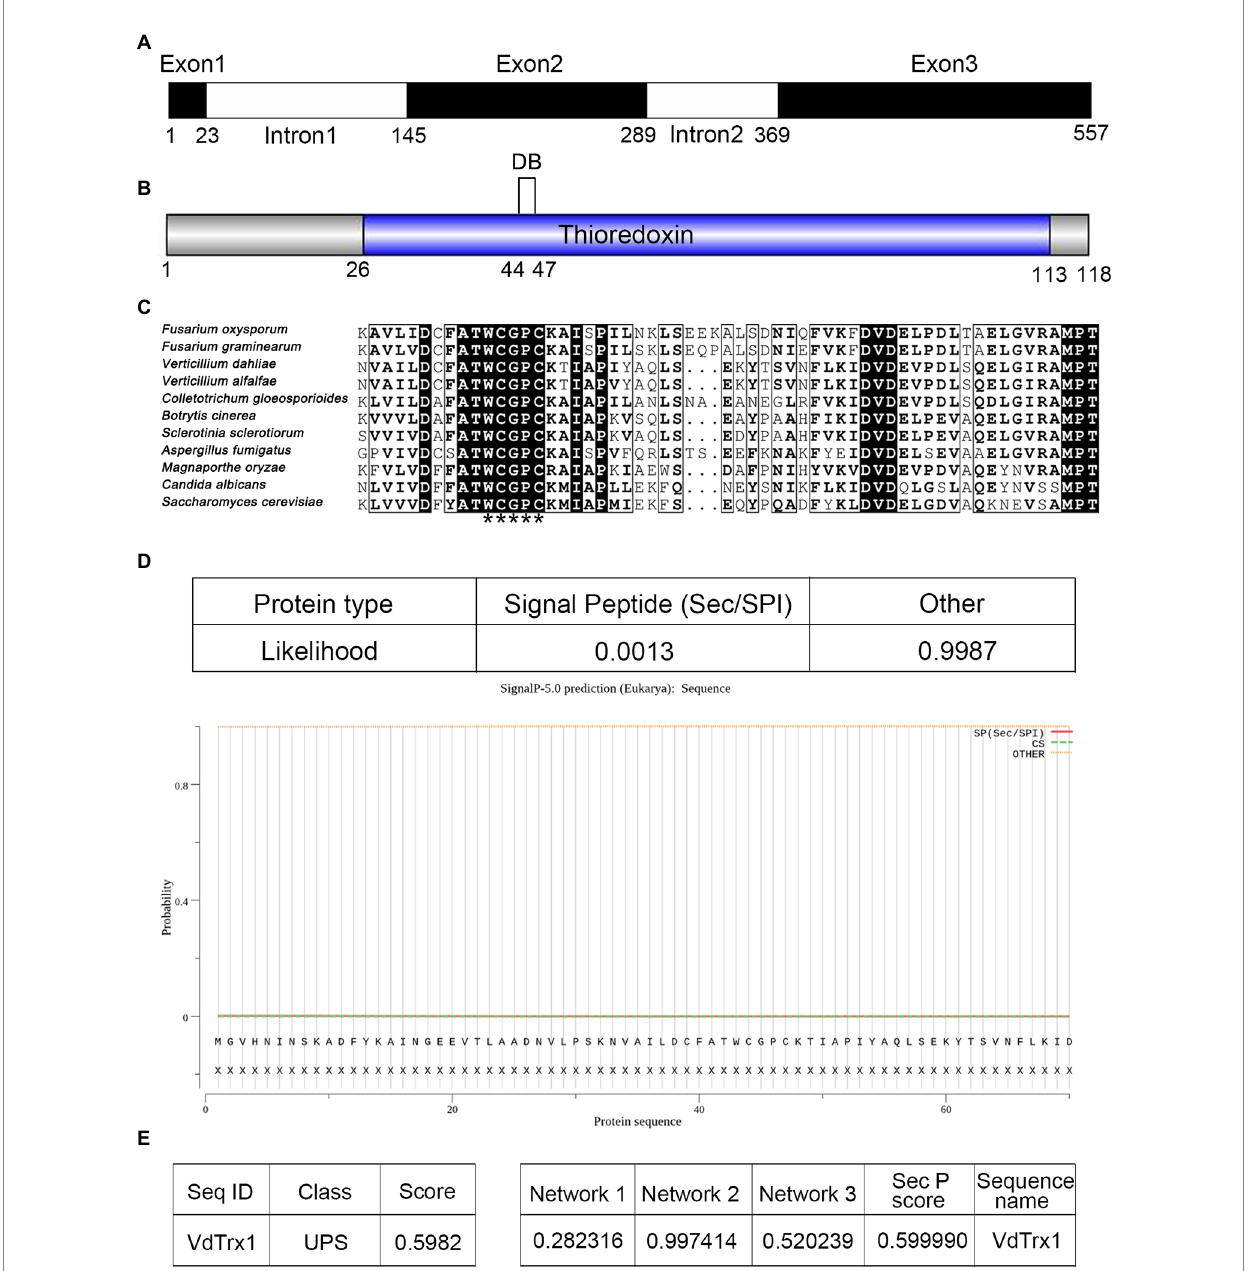
FIGURE 1 Gene cloning and bioinformatic analysis of VdTrx1 from Verticillium dahliae . (A) Structure of VdTrx1 . Exons are black boxes and introns are white boxes. (B) Conserved domain of VdTrx1 predicted by CD-Search of NCBI. DB represent disulfide bond. (C) Alignment of conserved region of thioredoxins. Thioredoxin-specific redox-active sites are marked by asterisks. GenBank accession number of aligned sequences are V. dahliae (VEDA_00080); Verticillium alfalfae (XP_003005517.1); Fusarium oxysporum (EGU81922.1); Fusarium graminearum (ESU16261.1); Magnaporthe oryzae (EHA47211.1); Botrytis cinerea (EMR86794.1); Aspergillus fumigatus (XP_753517.1); Colletotrichum gloeosporioides (EQB49288.1); Candida albicans (XP_719372.1); Saccharomyces cerevisiae (YLR043C). (D) Signal peptide prediction of VdTrx1 using SignalP 5.0 program. OutCyte 1.0 (E) and SecretomeP 2.0 (F) were used to predict unconventional secretion characteristic of VdTrx1. UPS, unconventional protein secretions; Network 1, score of amino acid composition; Network 2, score of secondary structure prediction; Network 3, score of transmembrane helix prediction; SepP score, the average of three network